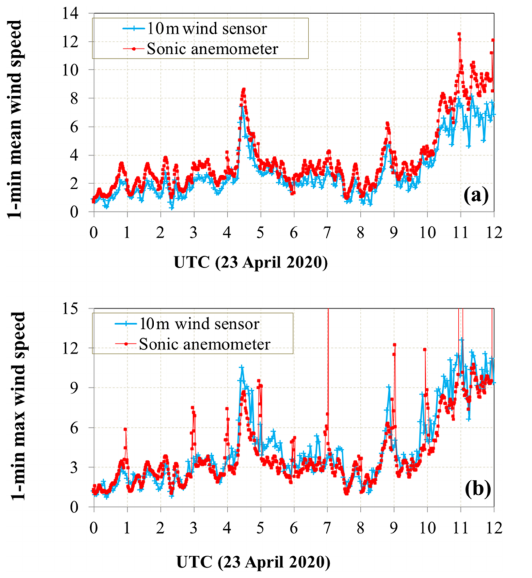
Figure 3. (a) Mean wind speed from standard anemometer at 10m height compared with the sonic aenomometer at 1.5m. The aver- aging window is 3min. (b) As in (a) except the maximum wind speed is shown. The high frequency sonic anemometer data were degraded to match the standard